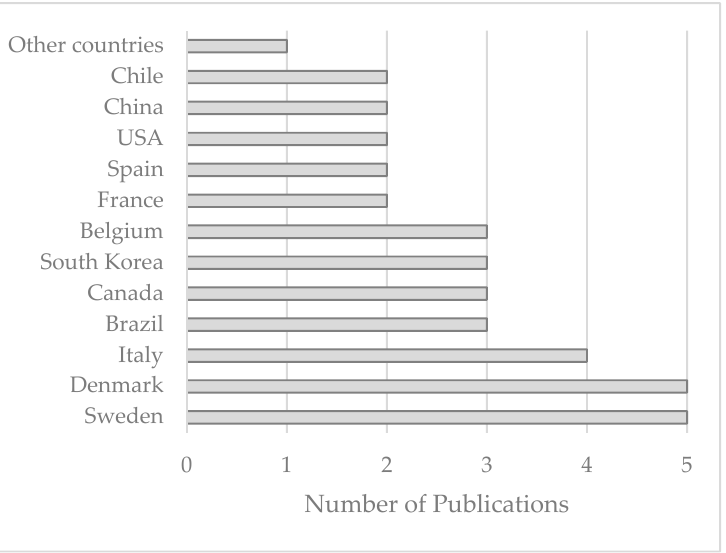
Figure 5. Contributions from different countries from 1984 to September 2022 .